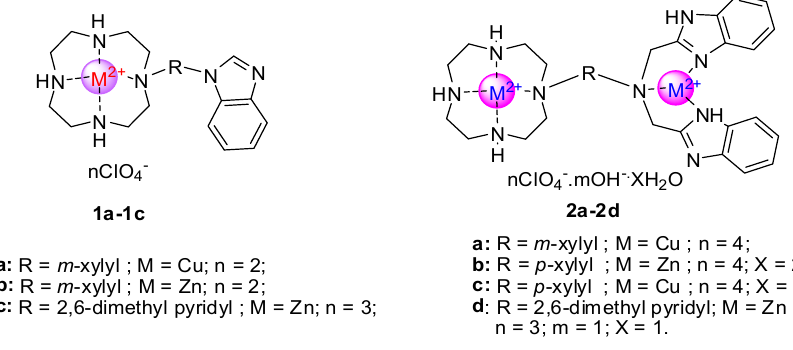
Scheme 1. Structures of target benzimidazole complexes.